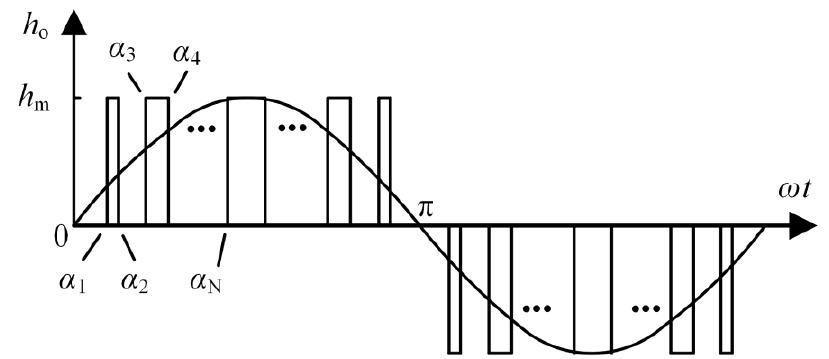
Figure 2. Theoretical waveforms of modulated and sin poles of the position angle.